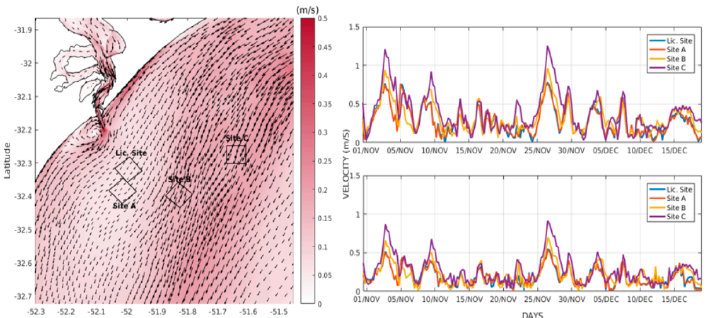
Figure 13. Left column—Calculated mean current velocity for the discharge period, where the color scale indicates the current velocity magnitude. Right column—Calculated time series of current velocities at the surface (top panel) and bottom (bottom panel) extracted at the points of maximum bottom evolution in each disposal site during the discharge